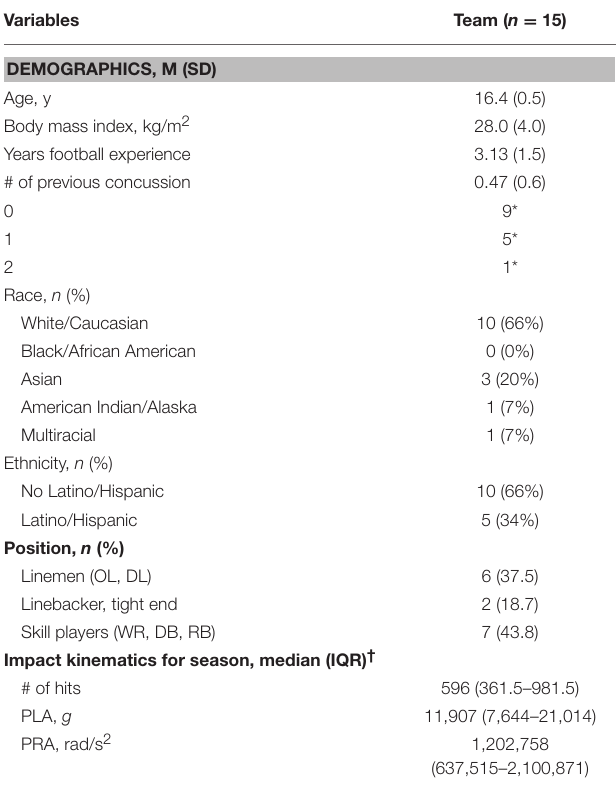
TABLE 1 | Demographics and head impact